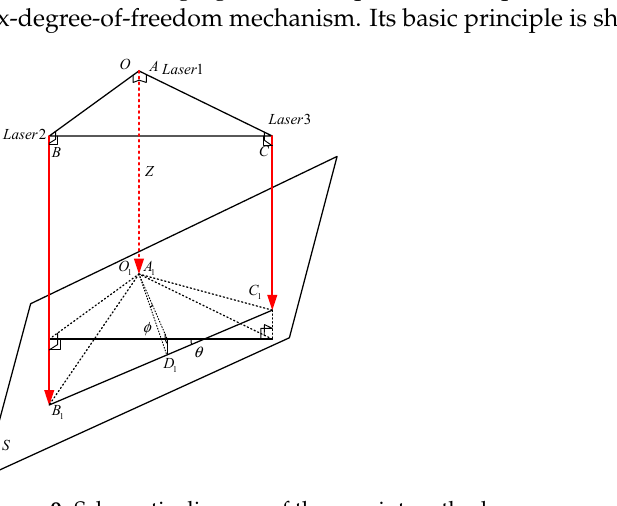
Figure 9. Schematic diagram of three-point method.